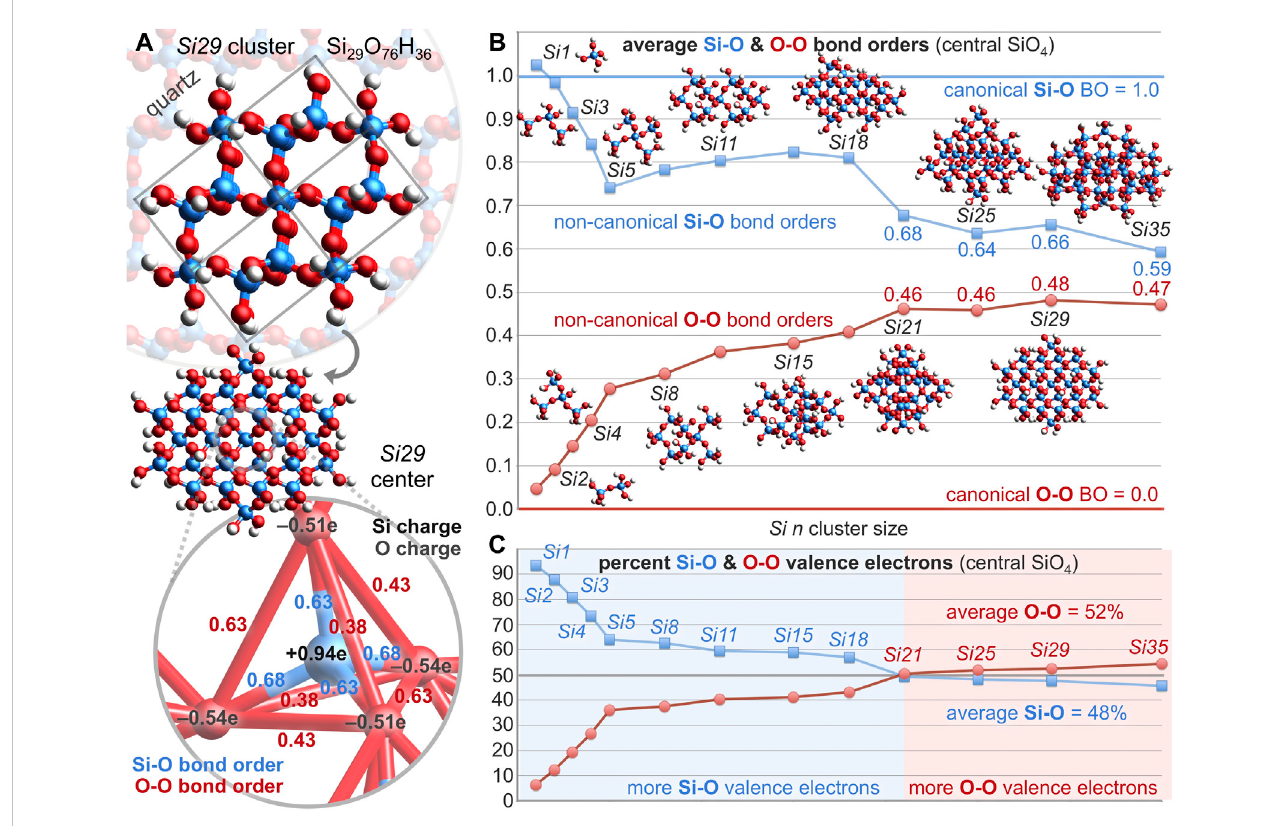
FIGURE 3 (A) For the central silicate of the quartz Si29 cluster, the Si-O bond orders average 0.66 (blue) and the O-O bond orders average 0.48 (red). (B) For the central silicate of clusters ranging from Si1 to Si35 , average bond orders deviate substantially from the canonical bond order of 1.0 for Si-O (blue) and 0.0 for O-O (red). (C) For the central silicate of large clusters ( Si21 – Si35 ), more valence electrons belong to O-O bonds(52%) than Si-O bonds (48%) — indicating that the O-O bond is the most prevalent bond on